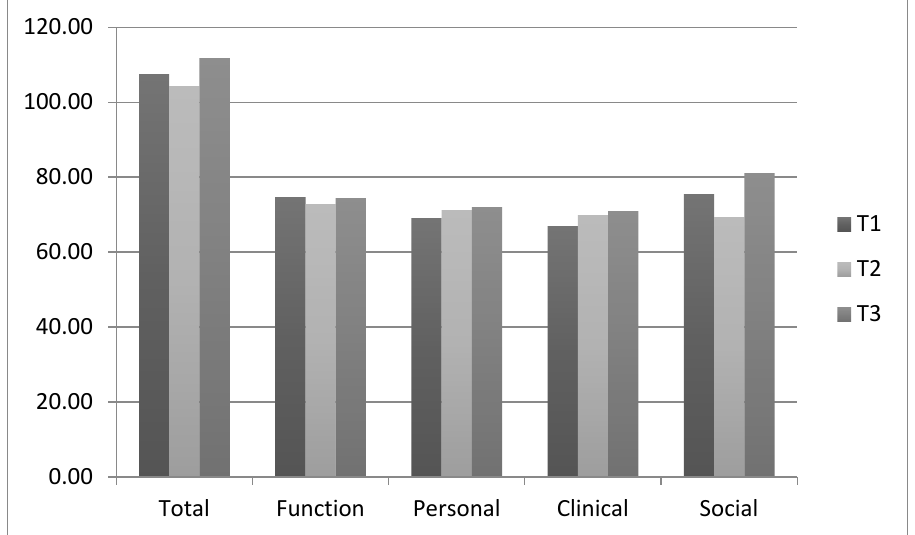
Figure 1. Sample Mean RAS ‐ DS scores.